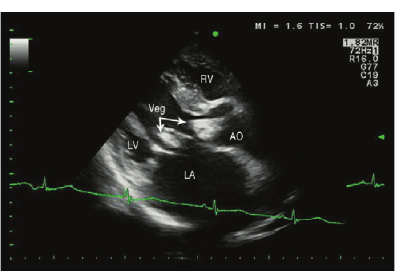
Figure 2. Immunoalkaline phosphatase staining of resected heart valve tissue using a monoclonal antibody reactive only with Bartonella henselae shows bacteria staining red (20X